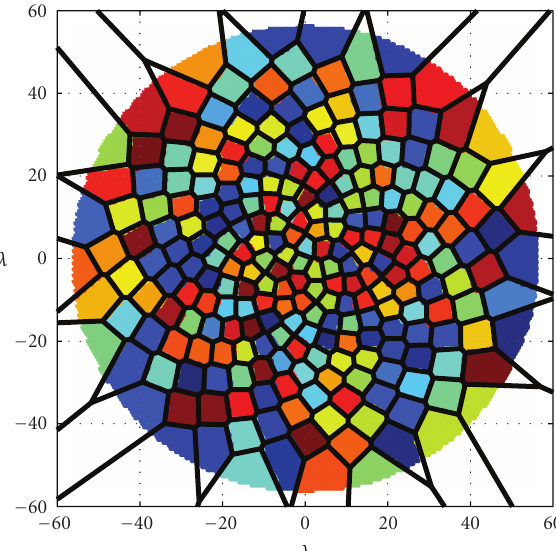
Figure 6: Subarray allocation and aperture subdivision corre- sponding to the Voronoi tessellation in Figure 5.